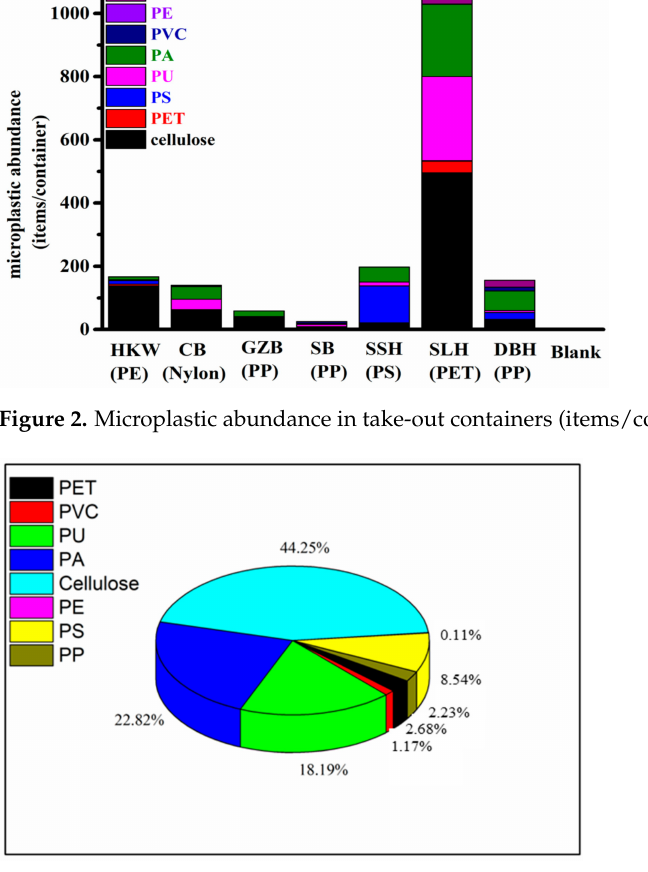
Figure 3. Polymer content of microplastics from takeaway food containers. Table 1. The percentage of same/other polymer microplastics for seven takeaway food